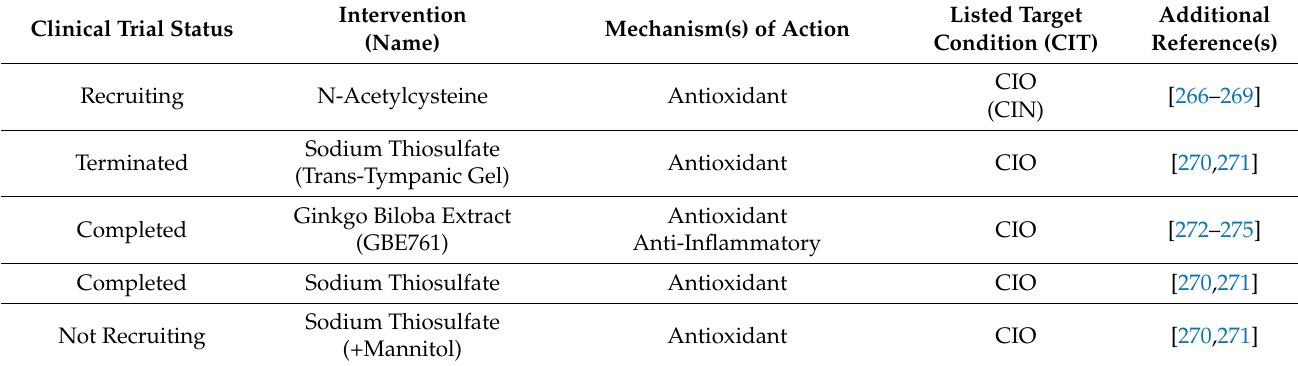
Table 3. Therapeutics for CITs in clinical trials